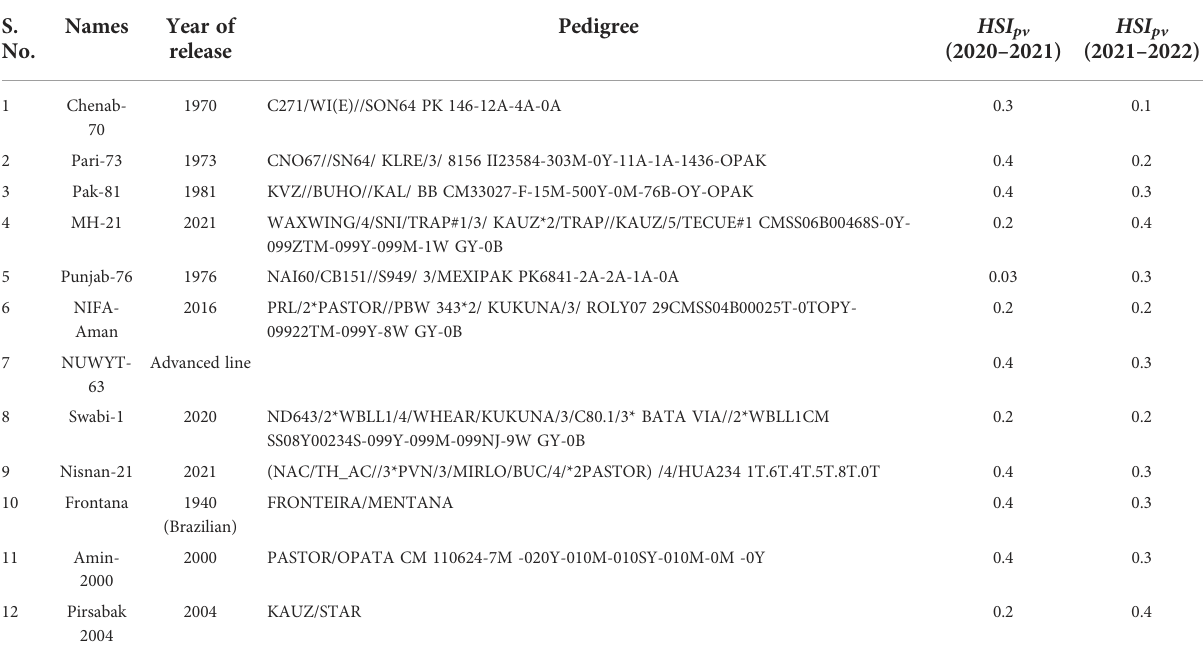
TABLE 2 Heat-tolerant line on the basis of HSI pv in the period 2020 – 2021 and 2021 – 2022. S. No.